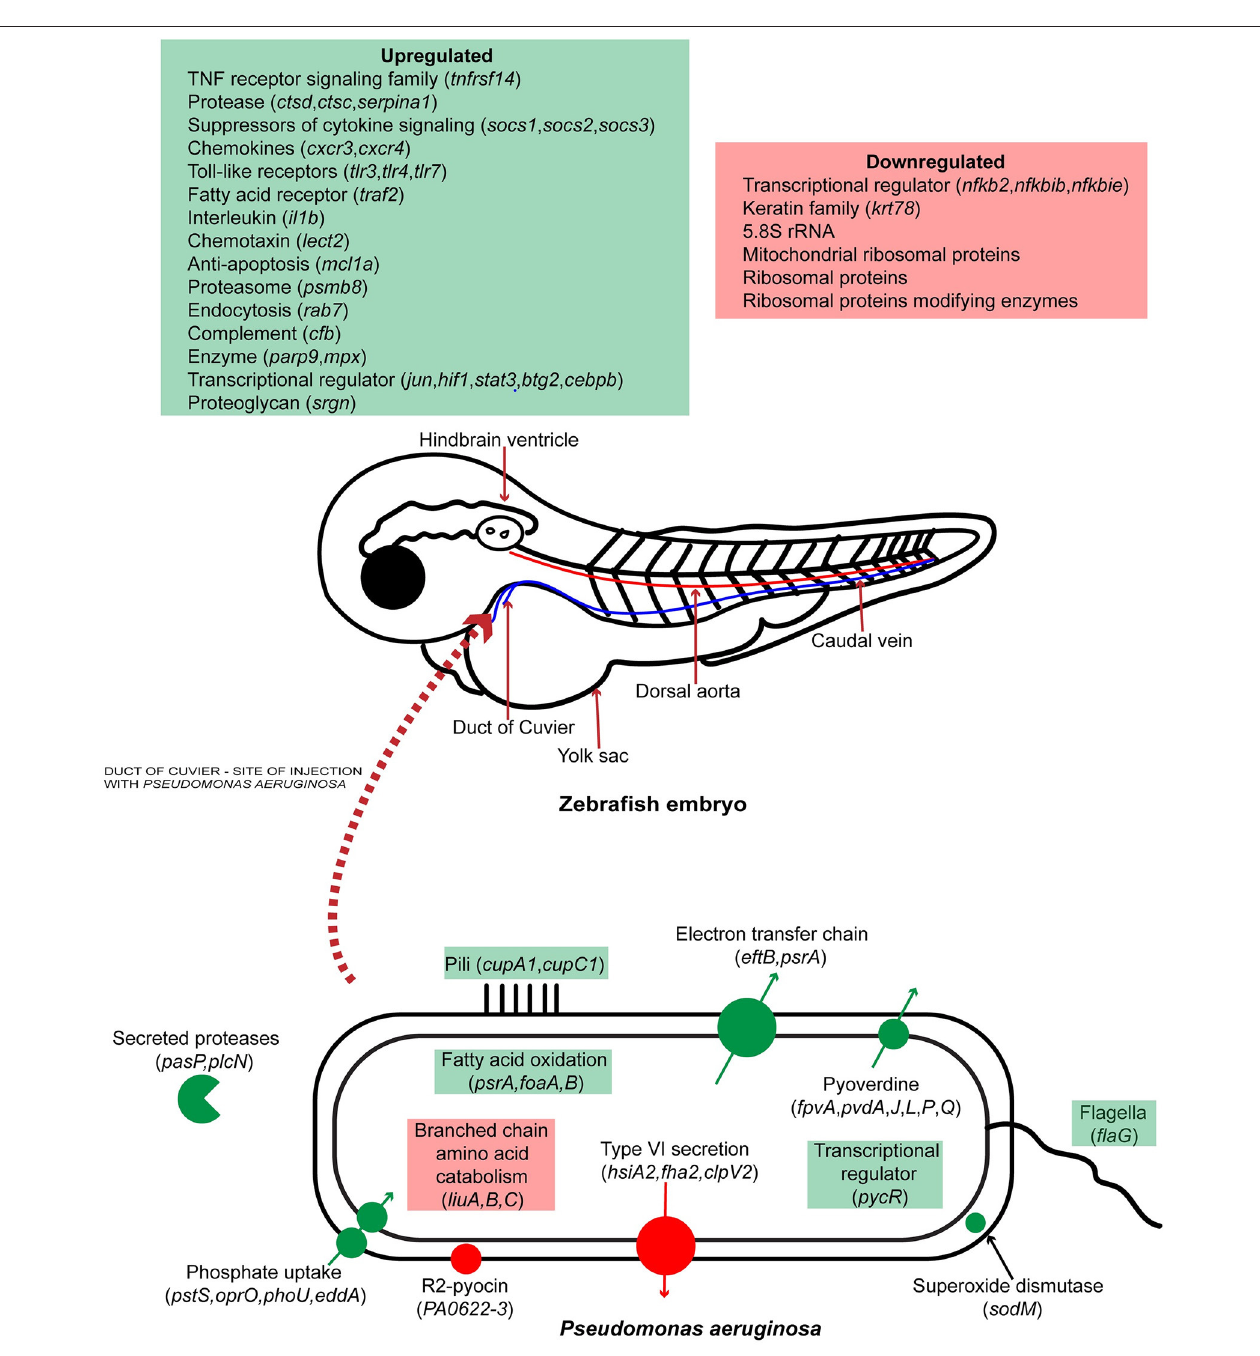
FIGURE 7 | Schematic representation of host-pathogen interactions of zebrafish embryos infected with P. aeruginosa PASS1. Up and down regulated processes and genes are highlighted in green and red,